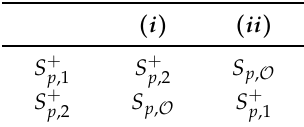
Table 2. The results of 4-isogenies in [13] on the